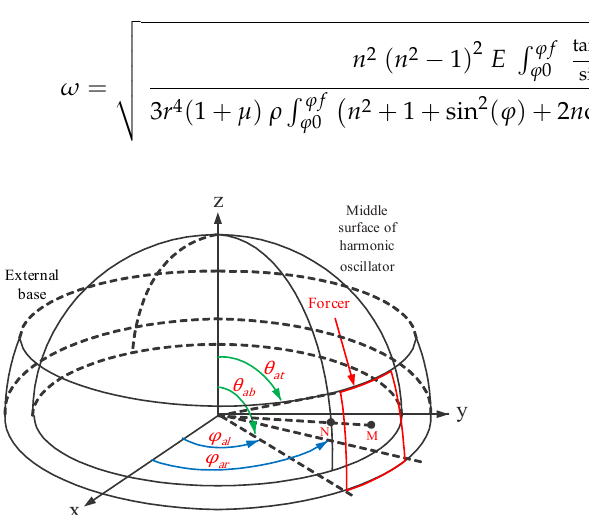
Figure 4. HRG drawn in spherical coordinates with capacitive excitation.